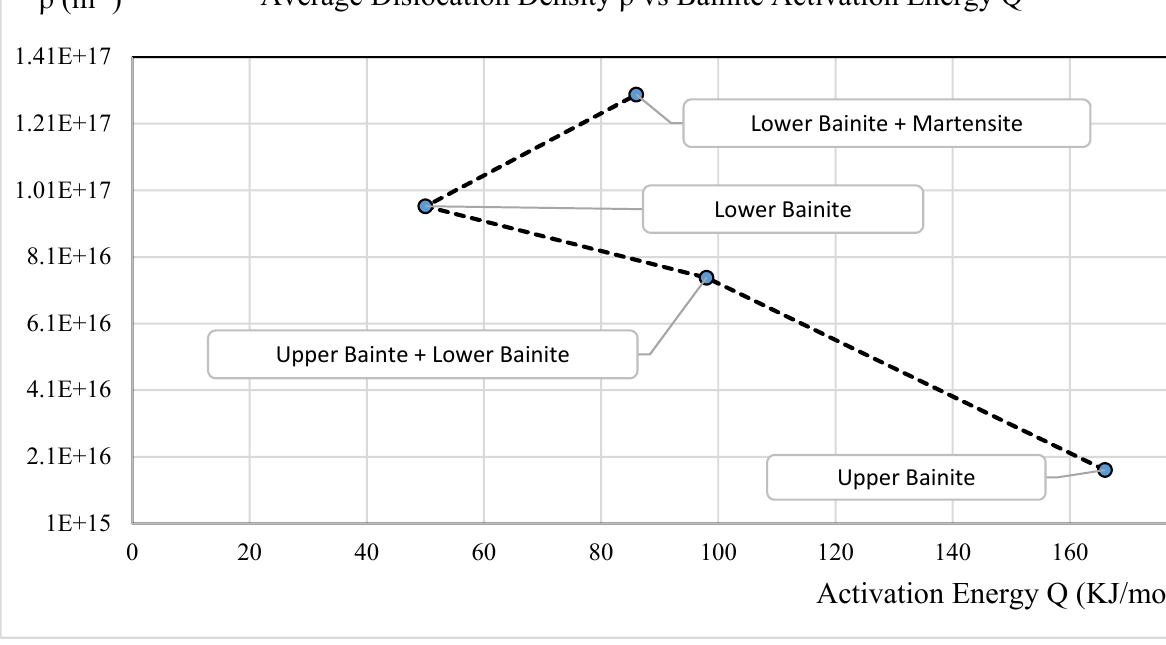
Figure 7. Average dislocation density vs. bainite activation energy.